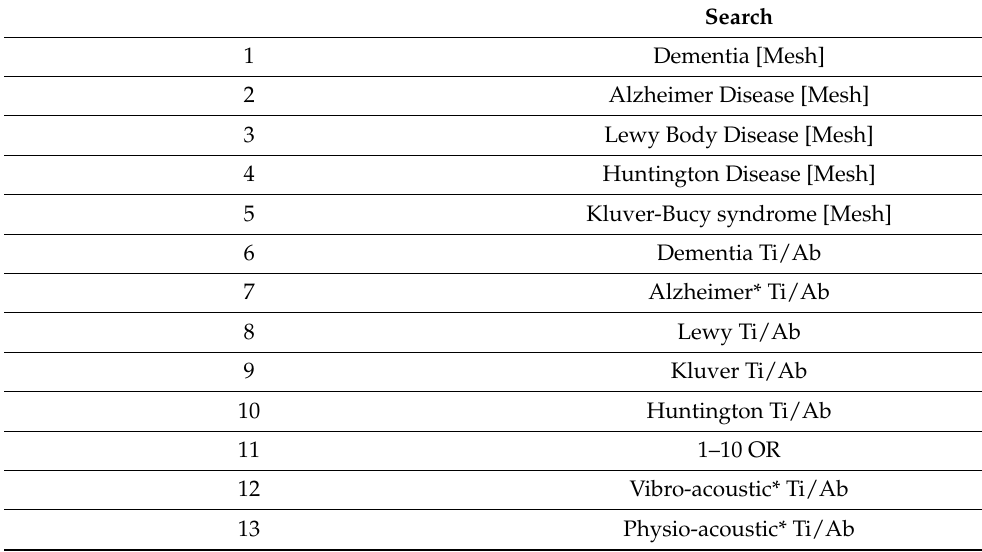
Table A3. Database: